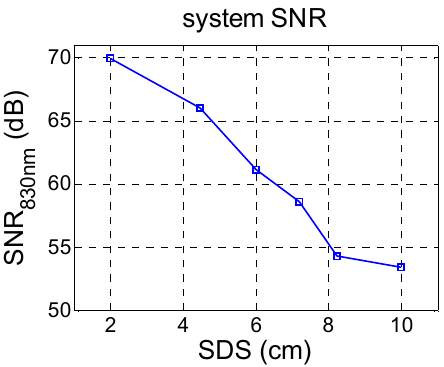
Figure 7. Single channel system signal-to-noise (SNR) vs. SDS measured on the phantom at 830 nm illumination.